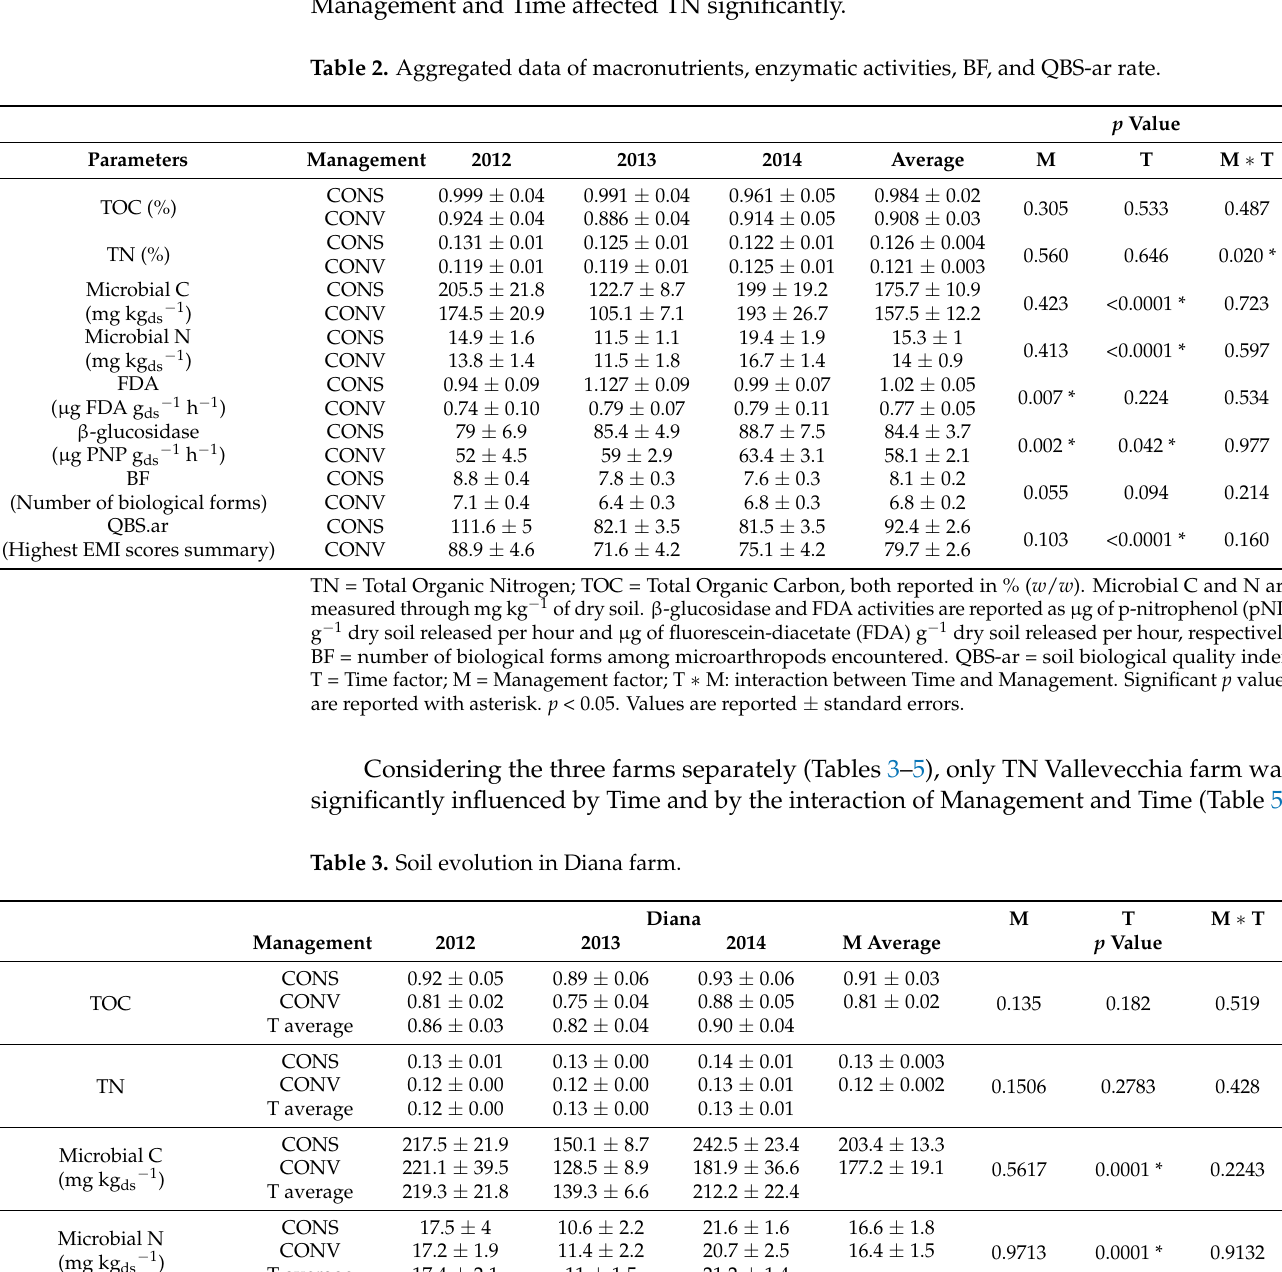
Table 2. Aggregated data of macronutrients, enzymatic activities, BF, and QBS-ar rate.